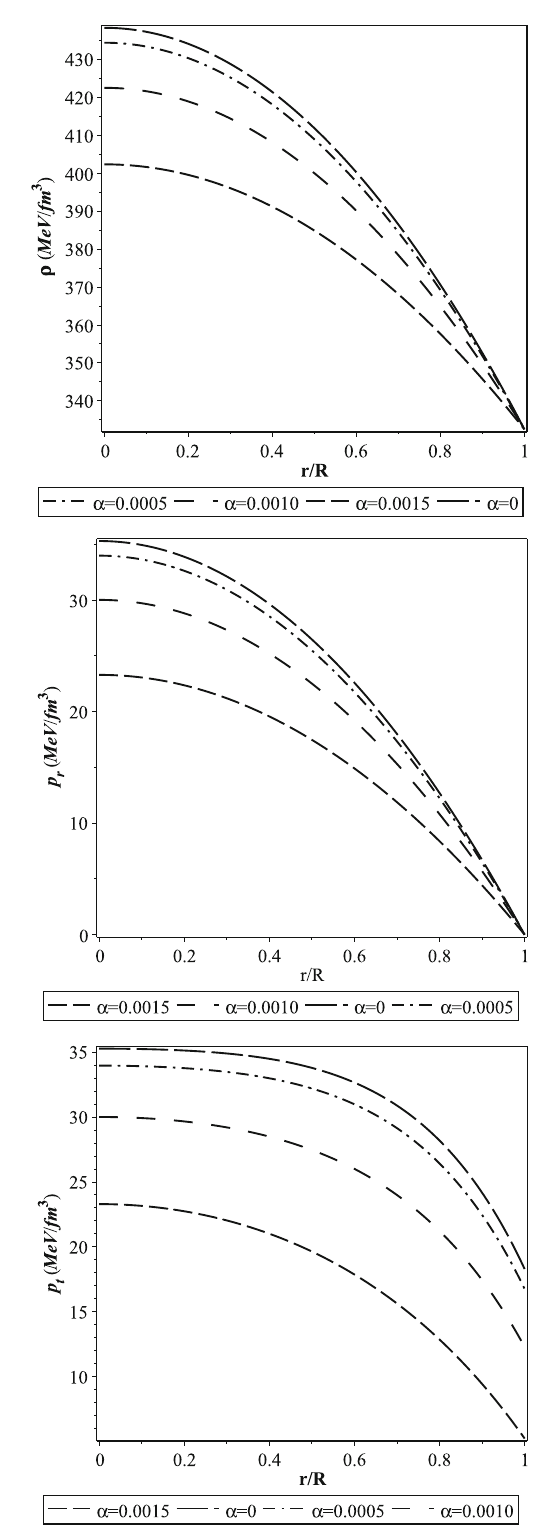
Fig. 2 Variation of (i) ρ (upper panel), (ii) p r (middle panel) and (iii) p t (lowerpanel)asafunctionoftheradialcoordinate r / R